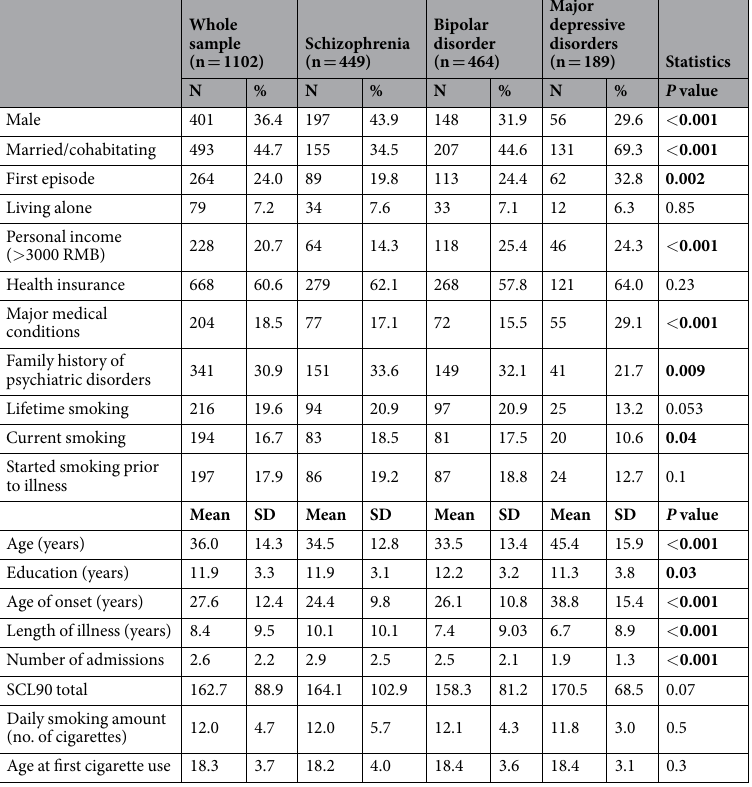
Table 2 compares demographic and clinical characteristics between smoking and non-smoking groups by diagnoses. In bipolar disorder, after controlling for male gender, living alone, personal income, having health insurance, age and age of onset, there was no significant difference between the smoking and non-smoking groups in physical (F